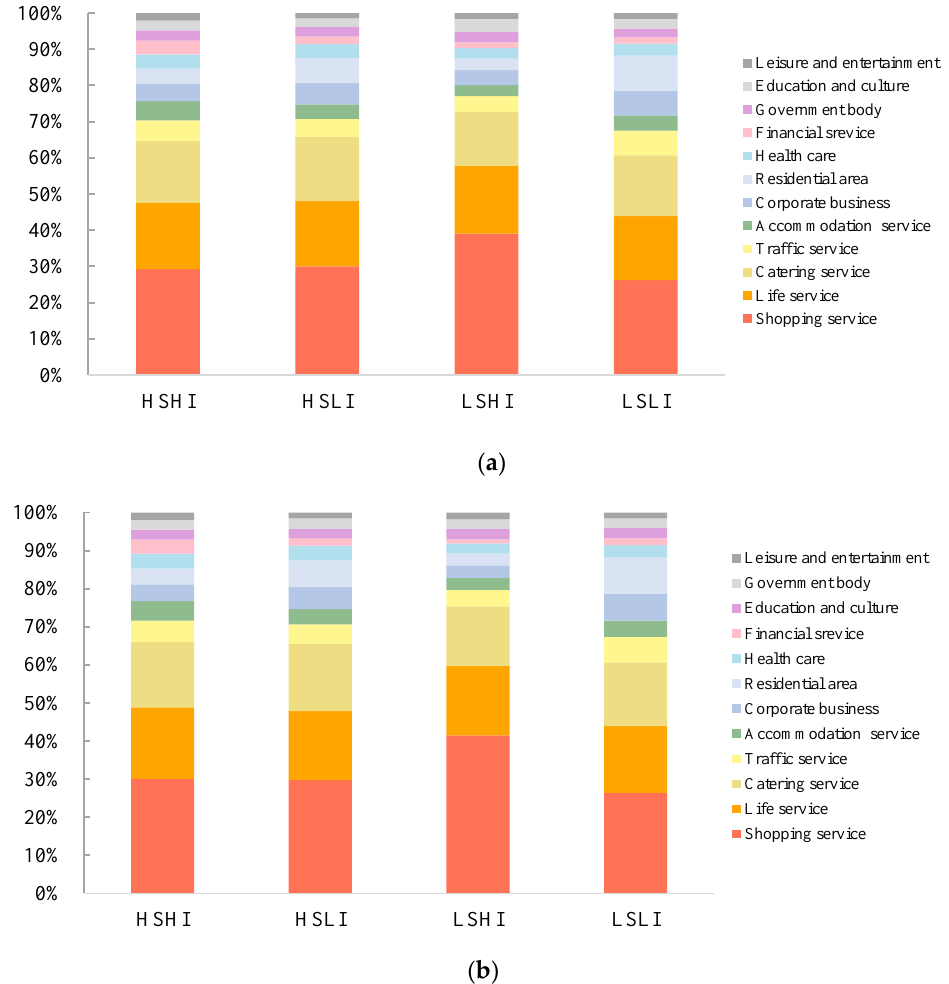
Figure 11. Land use composition of street vitality types. ( a ) Weekdays; ( b ) Weekends.